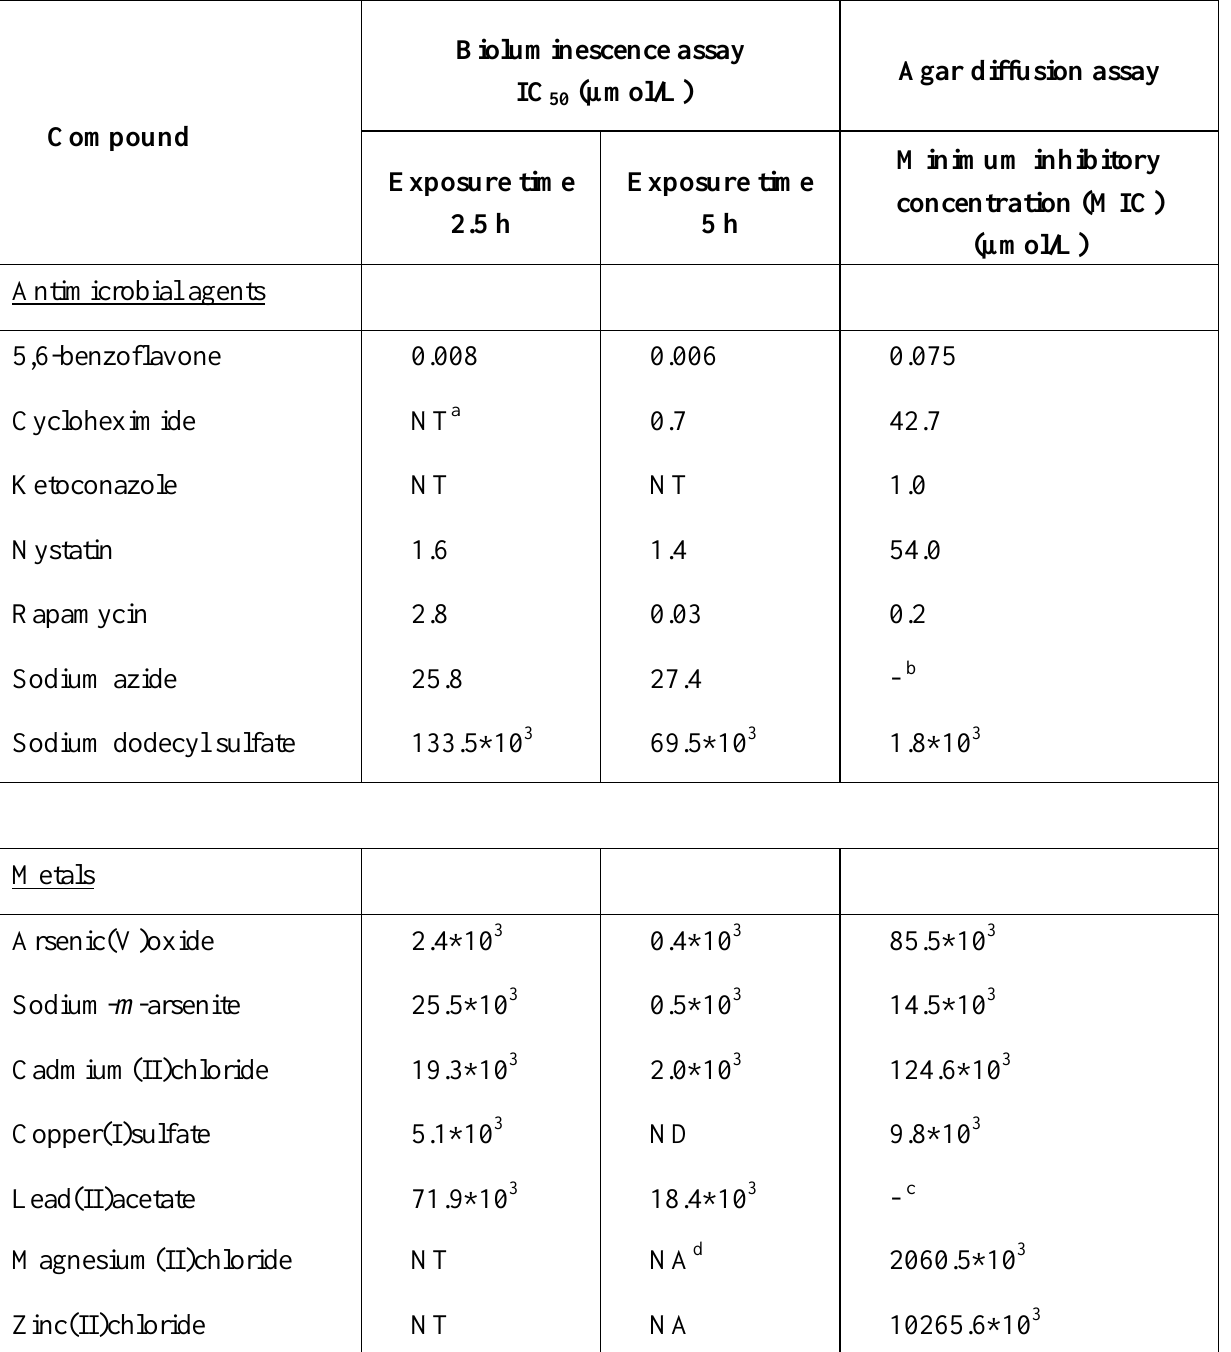
Table 1. The IC values (µmol/L) of the chemicals measured by the bioluminescence 50 assay having the exposure of 2.5 h or 5 h compared to the results (minimum inhibitory concentration, µmol/L) of the conventional agar diffusion